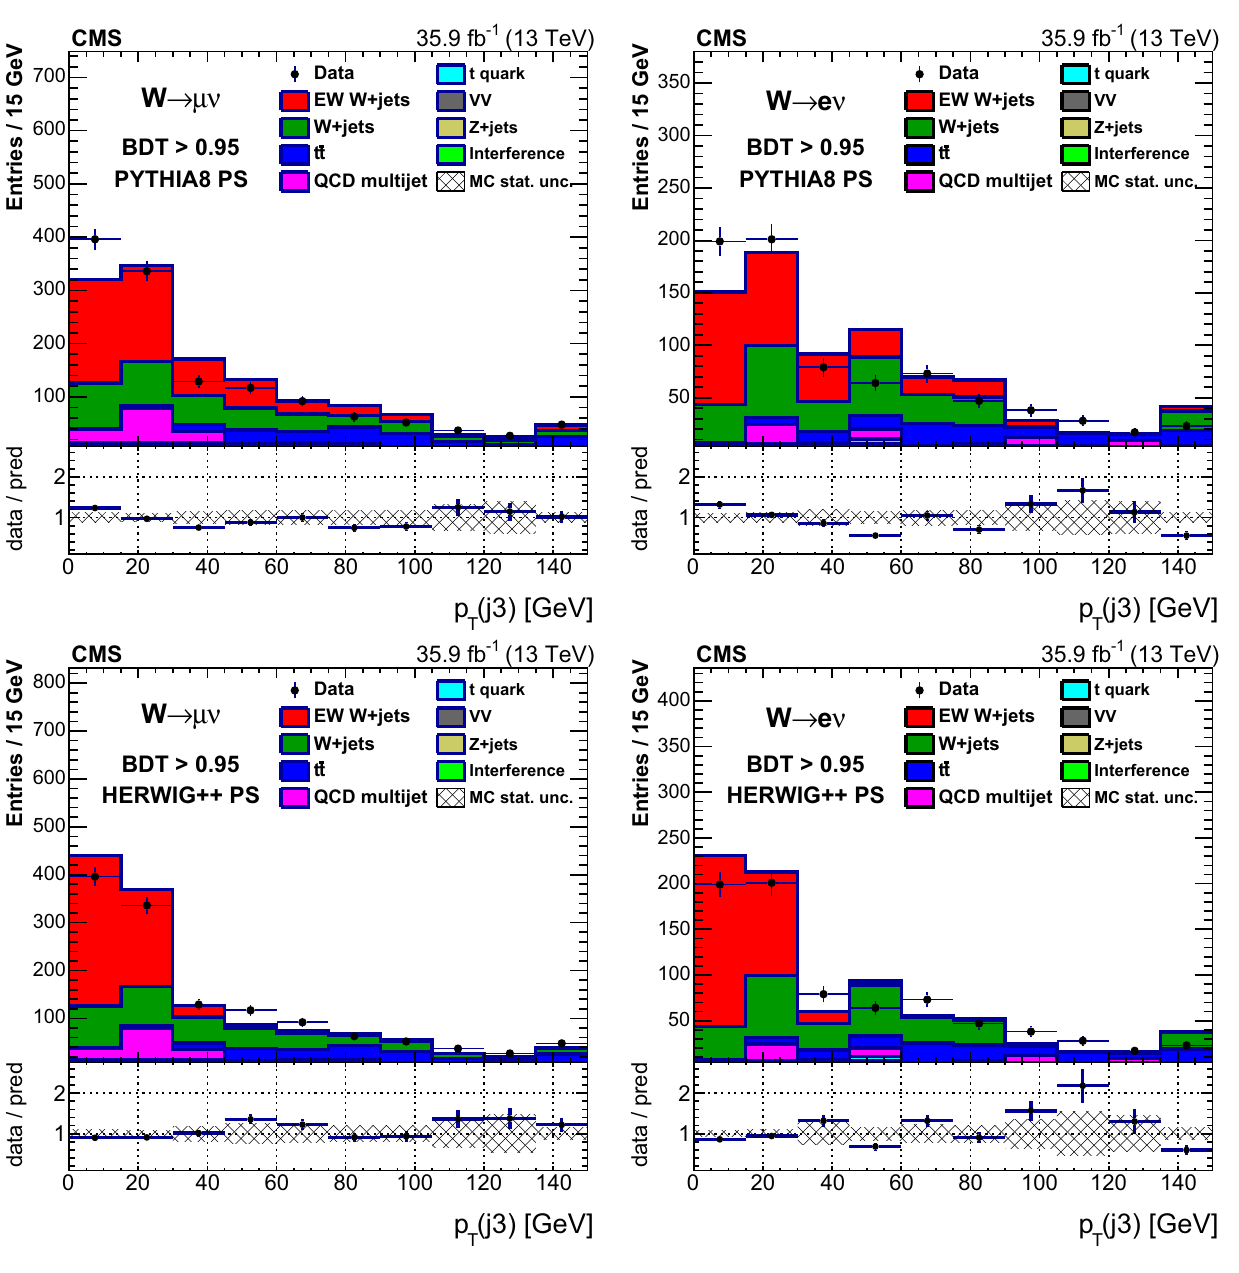
Fig. 15 Leading additional jet p T ( p T (j3)) for BDT > 0 . 95 in the muon (left) and electron (right) channels including the signal prediction from MadGraph 5_a mc@nlo interfaced with pythia parton shower-